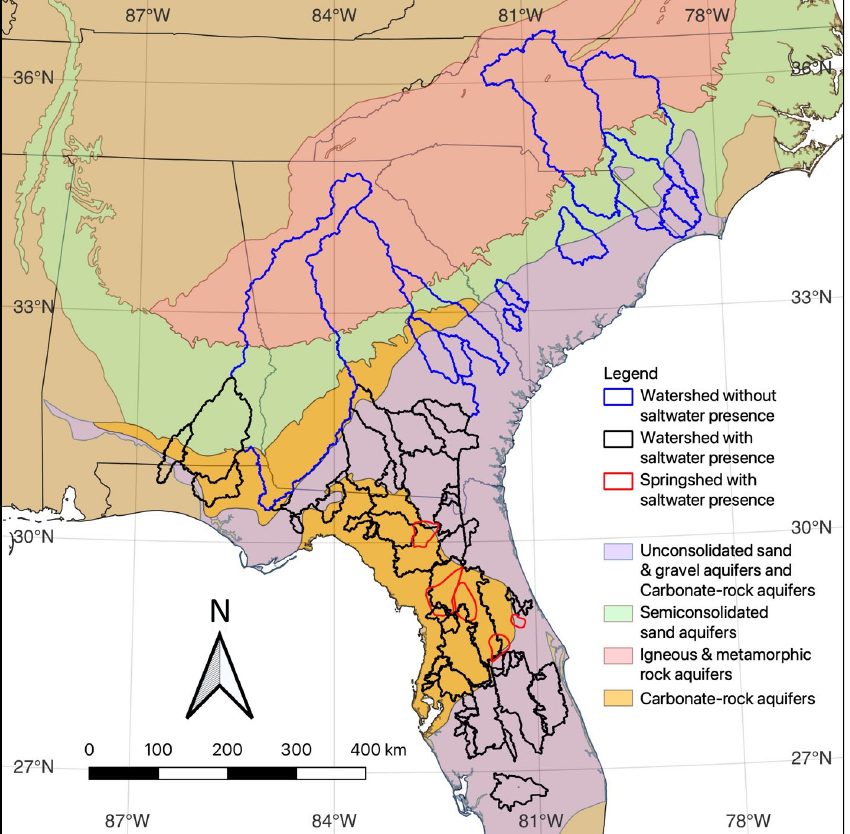
Figure 2. The 55 watersheds with saltwater presence (black and red outlines) are in areas with carbonate-rock aquifers and unconsolidated sand and gravel aquifers, and the 13 watersheds without saltwater presence (blue outlines) are in areas with similar aquifers in addition to igneous and metamorphic rock aquifers.